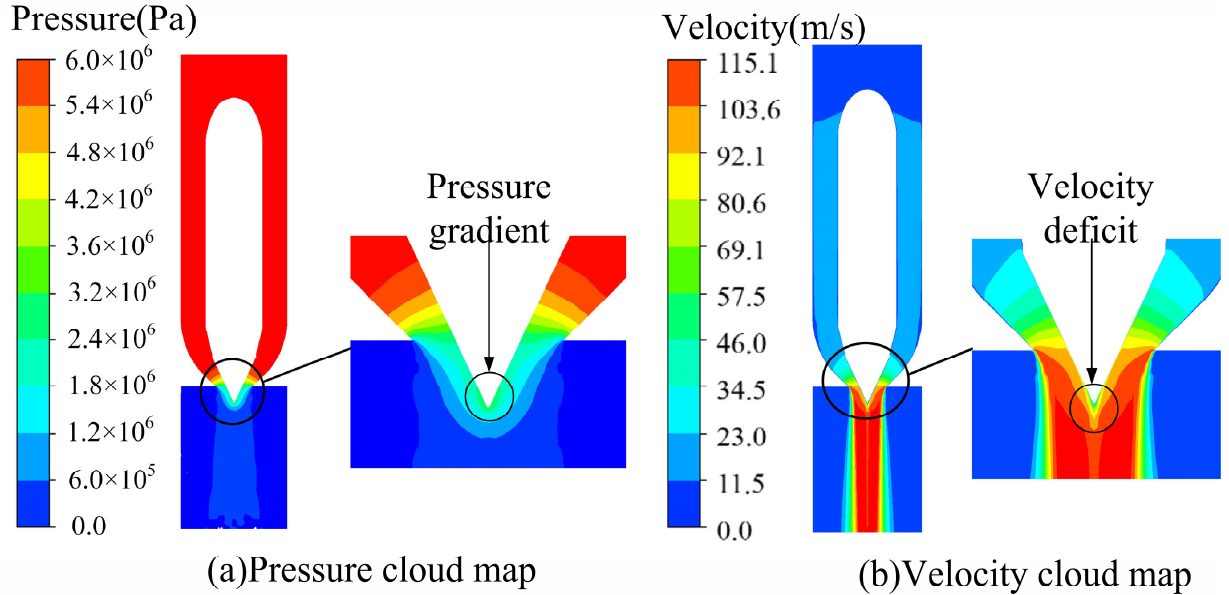
Figure 3. Flow field cloud in the injector.